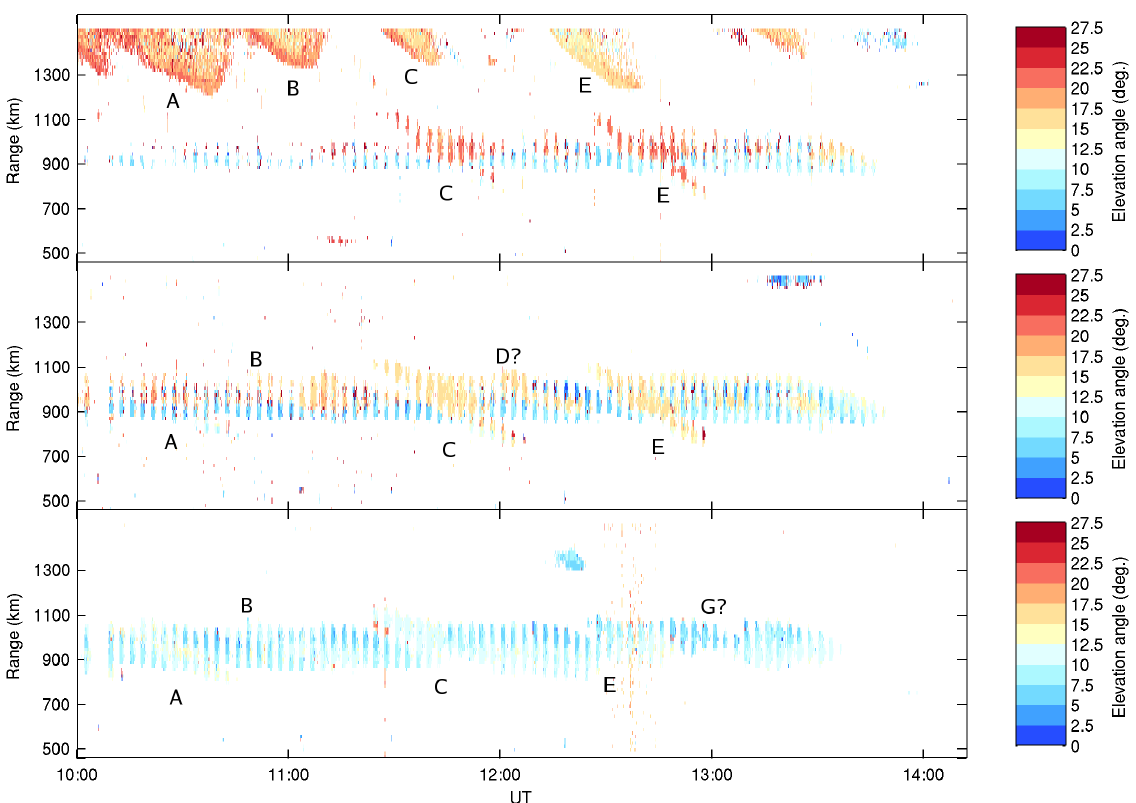
Fig. 3. Elevation angle measurements from the CUTLASS HF radar. Top panel: 13.2MHz; centre panel: 15.1MHz; bottom panel: 18.0MHz. The frequencies and time intervals correspond to the backscatter SNR data in the top three panels of Fig. 2.